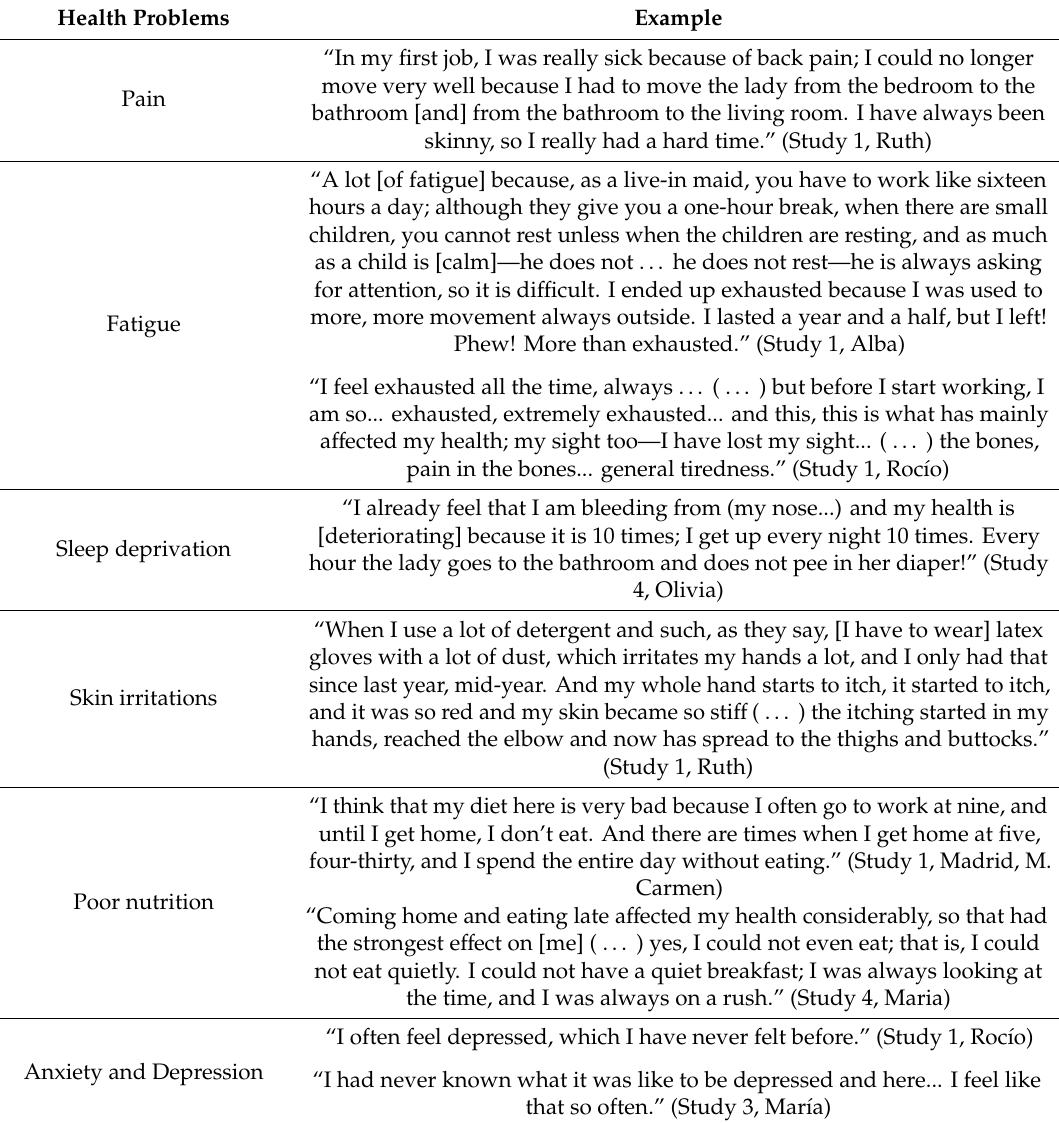
Table 2. Main Self-Reported Health Consequences of Intimate